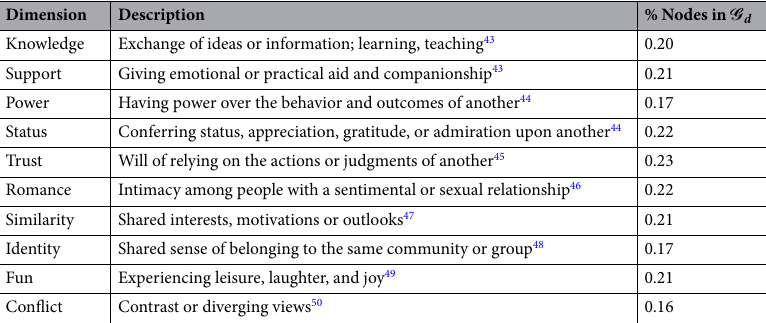
Table 2. The social dimensions of relationships surveyed by Deri at al. 9 . The last column reports the fraction of nodes of the full communication graph G that are included in each dimension-specific graph G d . The fraction of nodes in the last column is not exclusive, because nodes can be found in multiple dimension- specific graphs. Our work focused mainly on the dimensions of knowledge and support